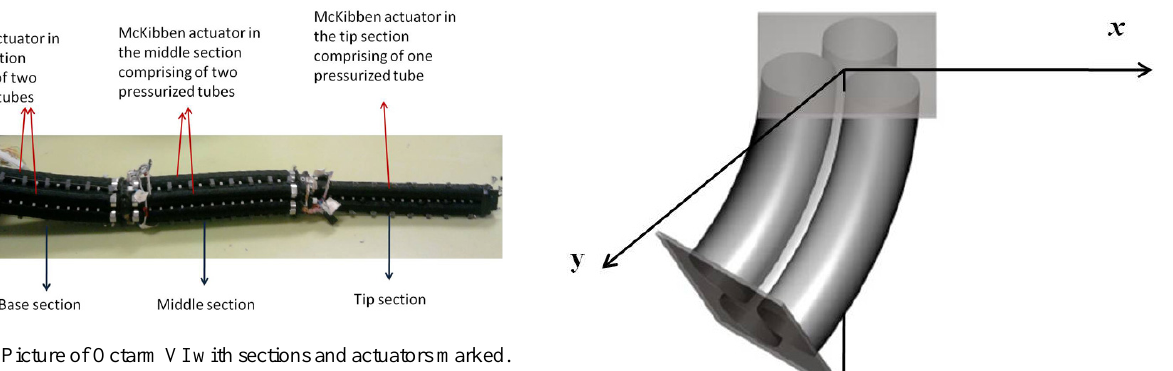
Figure 2. Picture of Octarm VI with sections and actuators marked.